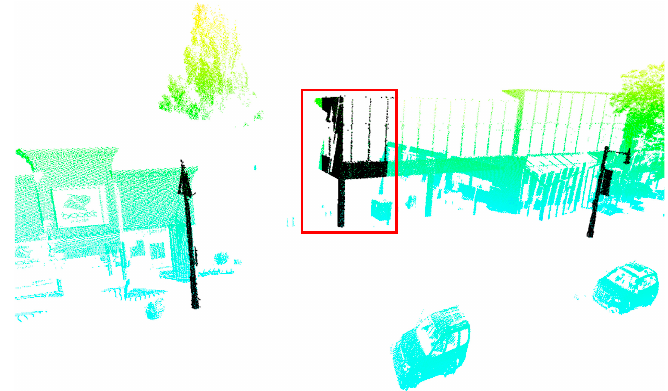
Figure 17. Wrongly detected building pillar as pole.